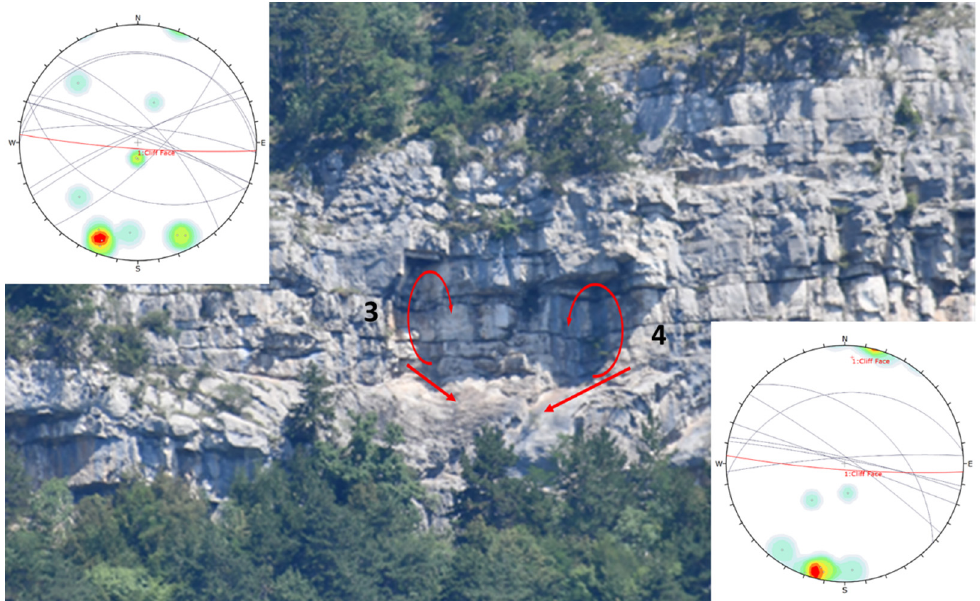
Figure 13. A view of the western part of the Raspadalica Cliff (Zone 2) with two signs of previous rockfall instability (3, 4). Stereographic presentations of discontinuities are present in the figure (3 left up, 4 right down,) and appropriate kinematic analyses do not indicate planar or toppling